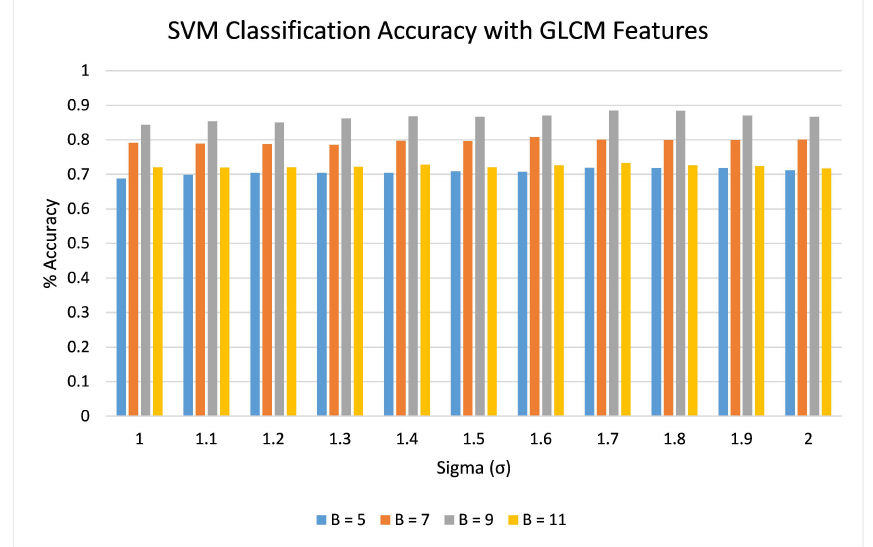
Figure 8. Classification accuracy (%) of SVM classifier with GLCM features with different block/window size ( B − window is B × B pixels).